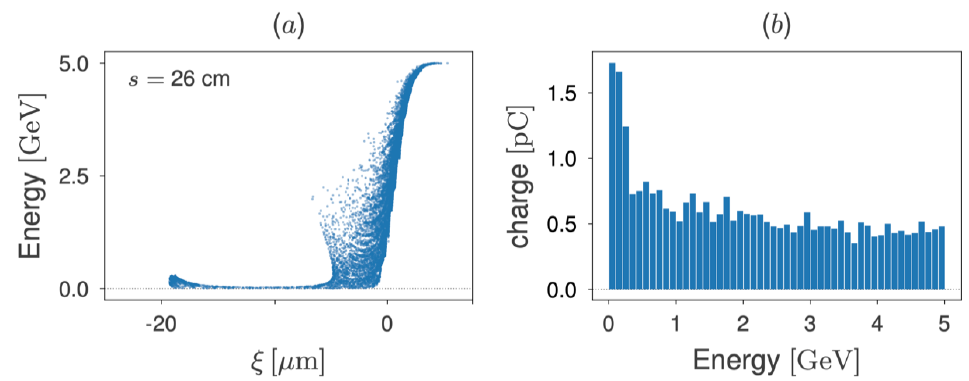
Figure 5. ( a ) The beam longitudinal phase space and ( b ) energy spectrum, after 26 cm propagation in plasma, for the EuPRAXIA 5 GeV beam.